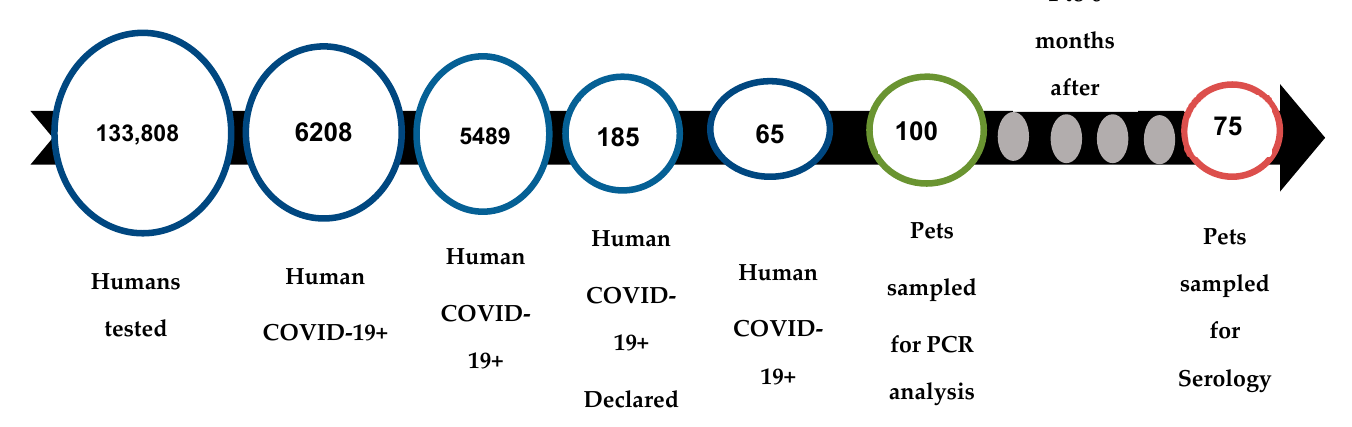
Figure 2. Pet’s enrolment